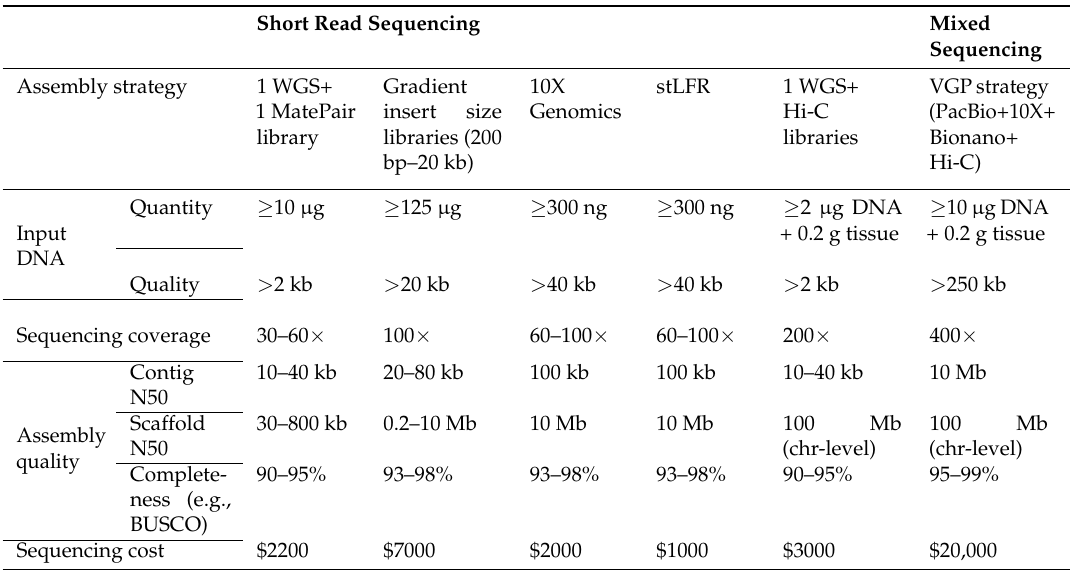
Table 1. Sequencing strategies for bird genomes. Abbreviations: WGS, whole genome sequencing; stLFR, single-tube long fragment sequencing: chr-level, chromosome level